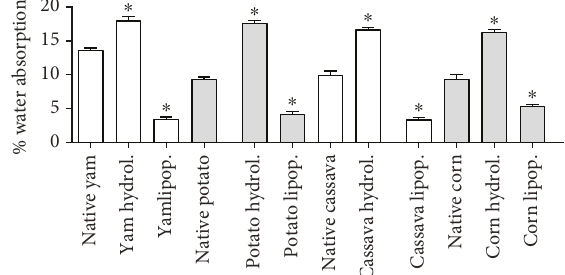
Figure 4: Graphical representation of the percentages of oil capture of all starches. ∗ Signi fi cant di ff erences compared to native corn p < 0 05 .